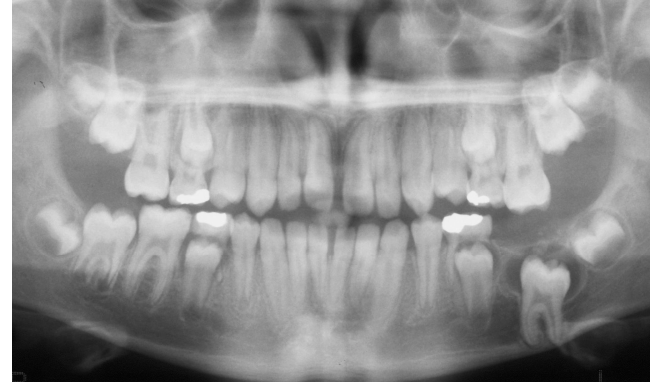
Figure 1. Pretreatment panoramic radiograph showing an impacted mandibular left molar associated with a rather large, well circumscribed, unilocular radiolucent lesion. The root is almost fully developed.